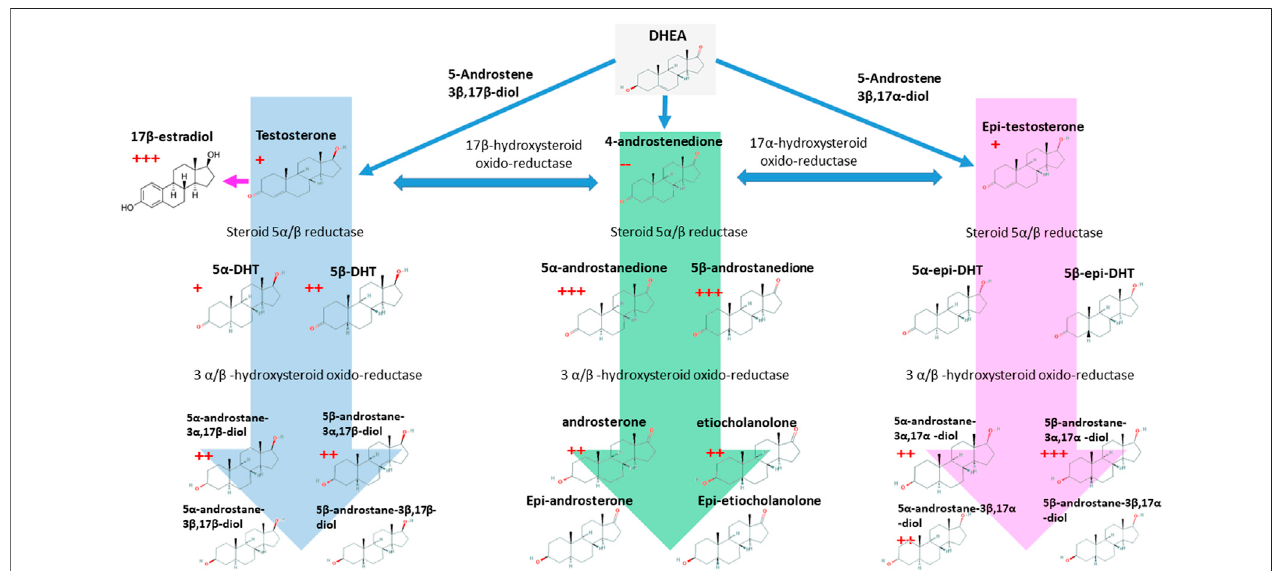
FIGURE6| TheC-19steroidspathwayanditslinkwiththe17 β -estradiol.Theredcrossesindicatedthenumberoftime-pointswhereeachmoleculeresultedtobe signi fi cantly over-accumulated in rhGH subjects. The red minus indicates the opposite. p -value <